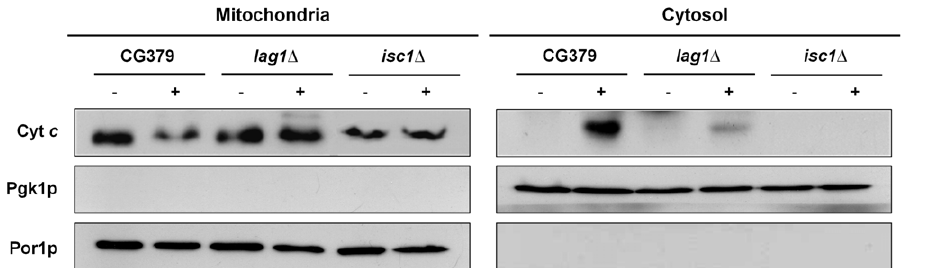
Figure 5. Cytochrome c release. Western blot analysis of cytochrome c in S. cerevisiae strains CG379, isc1 D and lag1 D before ( 2 ) and after ( + ) exposure to 180 mM acetic acid, pH 3.0, for 200 min, in both mitochondrial and cytosolic fractions. Cytosolic phosphoglycerate kinase (Pgk1p) and mitochondrial porin (Por1p) levels were used as loading control of cytosolic and mitochondrial fractions, respectively. A representative experiment is shown of at least two independent experiments with similar